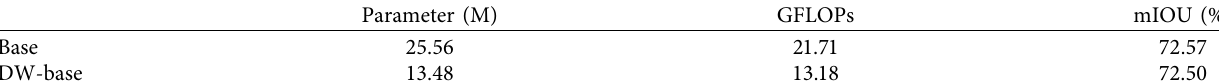
Figure 7: Base Model. Trans is to use 1 ∗ 1 convolution to change the number of channels. Sum is the addition of the corresponding elements of the feature map. Deconv uses the deconvolution of kernel size equal to 4, stride equal to 2, and padding equal to 2 to expand the feature map size. Table 1: Accuracy and parameter analysis of Base Model on the insulator dataset. ResNet-50 and depth-wise separable convolution (DW)— ResNet-50 refers to the replacement of all 3 × 3 convolution in the network with depth-wise separable convolutions. GFLOPs estimated model complexity for 3 × 512 × 512 input image.